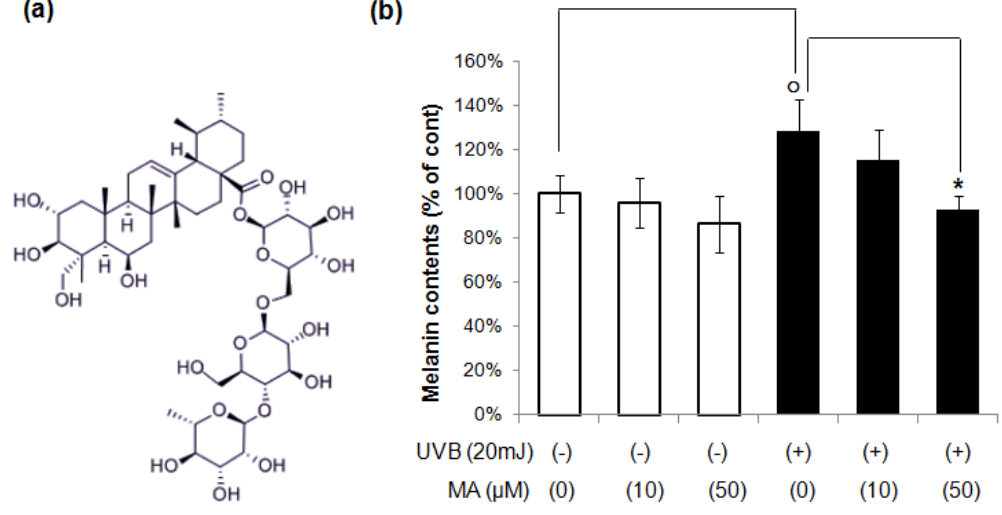
Figure 1. ( a ) Chemical structure of MA. ( b ) Melanocytes and HaCaT keratinocytes were co-cultured in a hanging cell culture insert system in the presence or absence of UVB irradiation (20 mJ/cm 2 ) using 12-well Millicell Hanging Cell Culture Inserts. After HaCaT cells in upper chamber were irradiated with UVB, MA was added to the indicated concentration and then placed above the melanocytes. After 4 days, lower-chamber melanocytes were collected for melanin assay. The data shown are the means ± S.D., n =